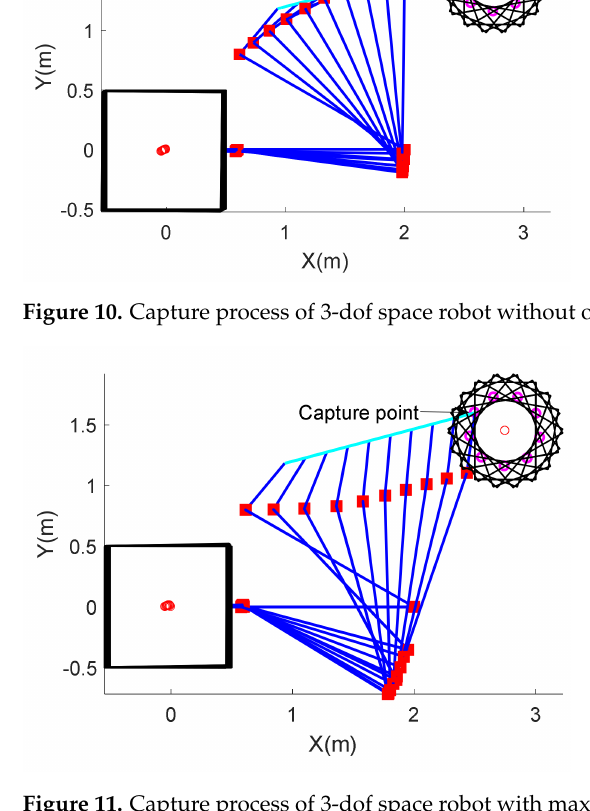
Figure 11. Capture process of 3-dof space robot with maximum-contact-force optimization. Table 4. Simulation comparison results of 3-dof space